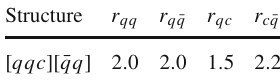
Table 12 The RMS